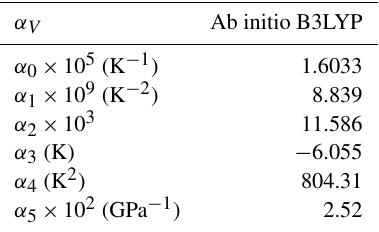
Table 2. Ab initio B3LYP thermal expansivity of Mg 2 SiO 4 ring- woodite up to mantle transition zone conditions ( α V in K − 1 ).